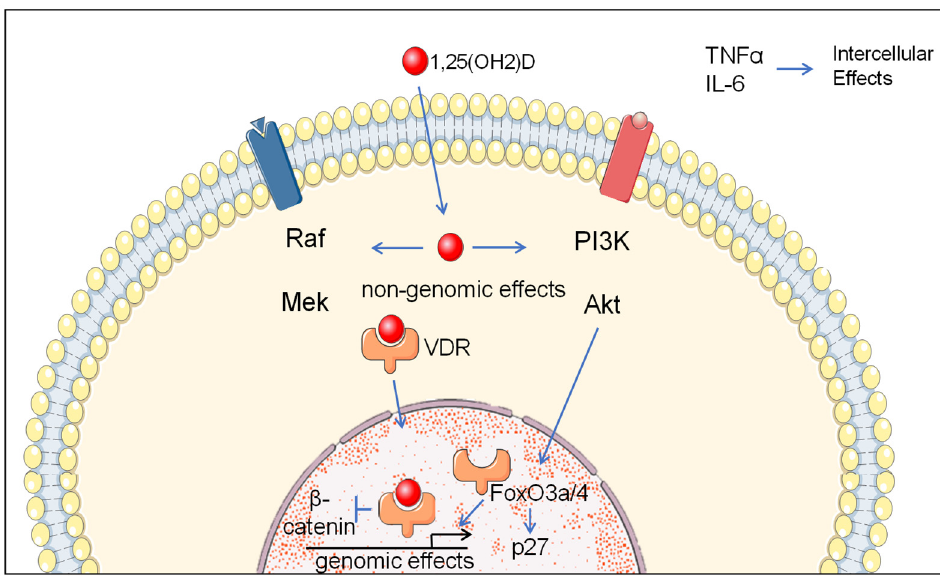
Figure 1. Vitamin D-regulated pathways in cancer. Cancer-related intracellular non-genomic and genomic mechanisms of molecular pathway regulation by vitamin D and intracellular molecular factors regulated by vitamin D. Non-genomic activation of PI3K and MAP kinases occurs downstream of ligand-bound VDR. FoxO3a/4 signalling and the expression of p27 cyclin-dependent kinase accumulation can result from vitamin D/VDR activation of PI3K signalling. Genomic effects involve regulatory effects of nuclear ligand-bound VDR at responsive gene elements. Nuclear ligand-bound VDR also inhibits β -catenin signalling. Decreased TNF α and IL-6 signalling induced by vitamin-D can have intercellular effects by inhibition of pro-tumorigenic inflammation.